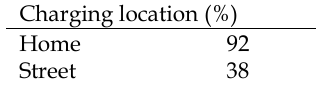
Table 9 Private users’ charging locations (percentage of participants)